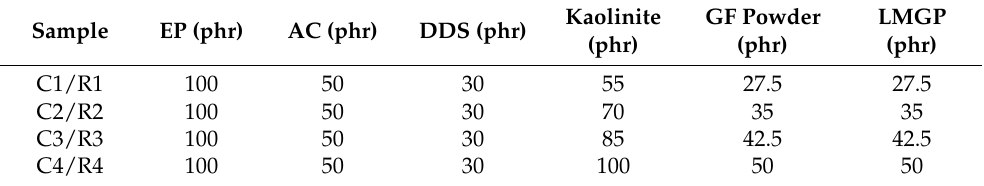
Table 1. The formula of the filler–resin castings and EP/QF ceramifiable composites.